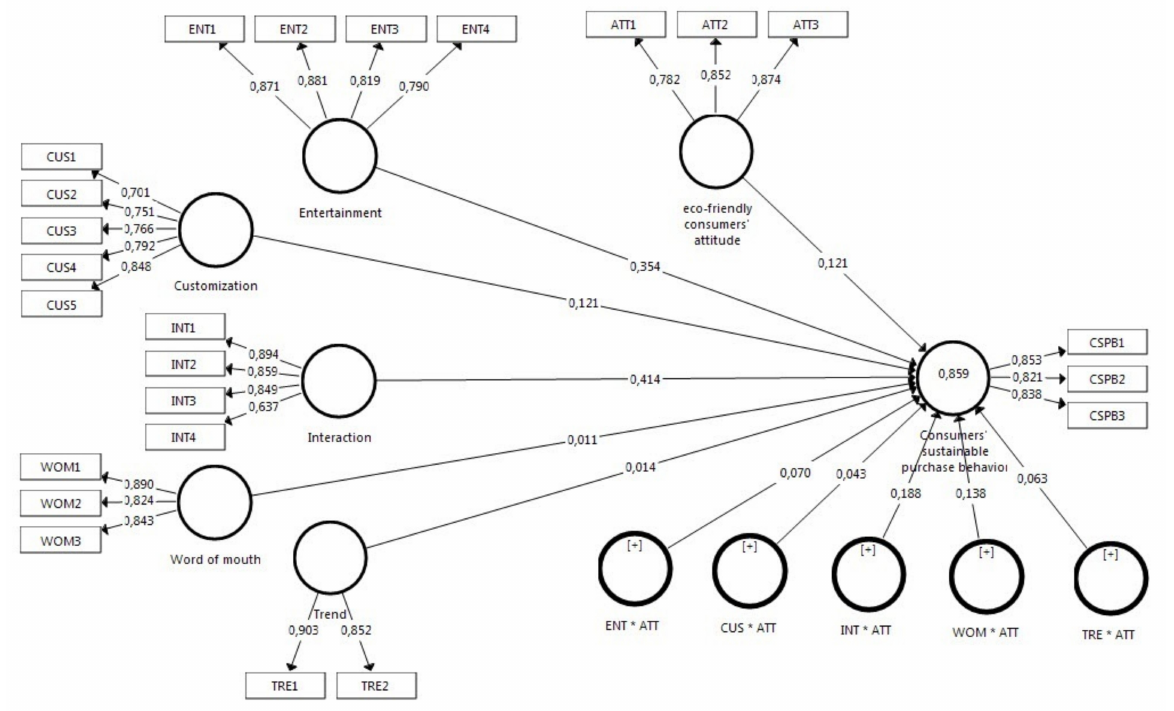
Figure 3. Path coefficients model (CUS: Customization, INT: Interaction, WOM: Word of Mouth, ENT: Entertainment, TRE: Trend, ATT: Eco-friendly Attitude, CSPB: Customers’ sustainable Purchase Behavior).